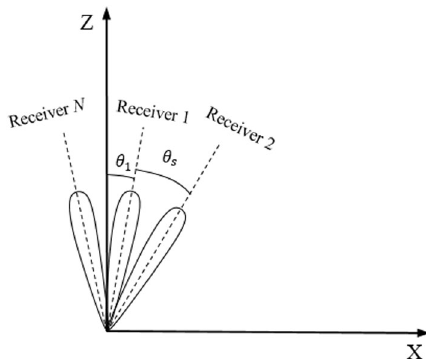
Fig. 2 The model of amplitude-comparison monopulse reconnaissance